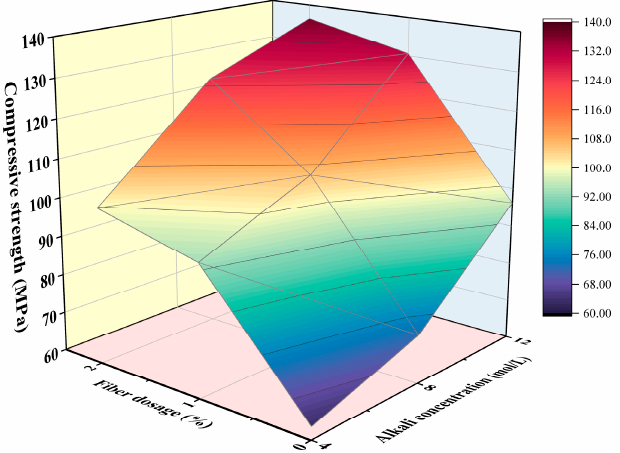
Figure 7. The combined influence of steel fiber dosage and NaOH solution concentration on the compressive strength of slag/metakaolin-based UHPGC. compressive strength of slag/metakaolin-based